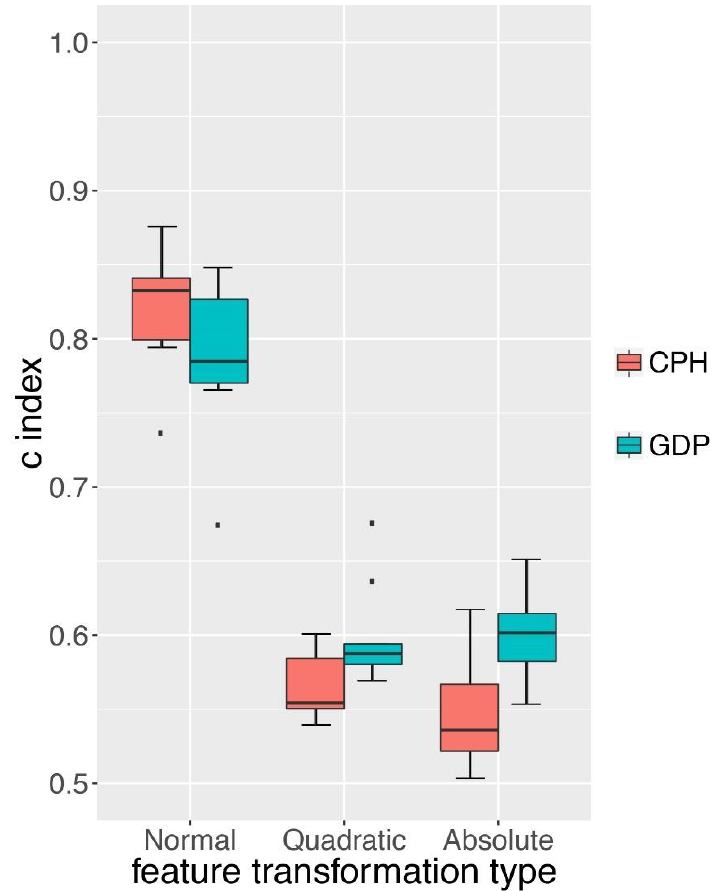
Figure 4. Comparison between GDP and CPH models. C-index comparison between GDP and CPH under different types of feature transformations. Normal: no additional layer of function was applied to the simulation model. Quadratic: quadratic function layer was added to the simulation model. Absolute: absolute function layer was added to the simulation model. Simulation details can be found in S3A–C of Table S2.